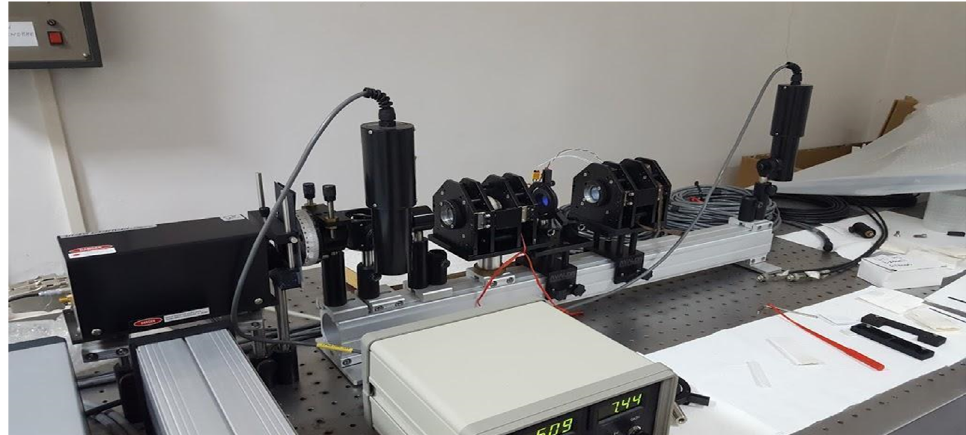
Fig. 3. The MOF-K cells mounted on the laser test facility